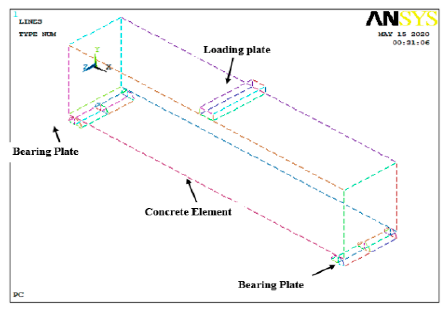
Figure 11. Modeling of beam (B1).